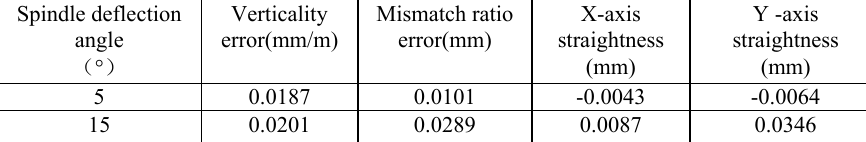
Table 1. Ballbar test data after correction of kinetic